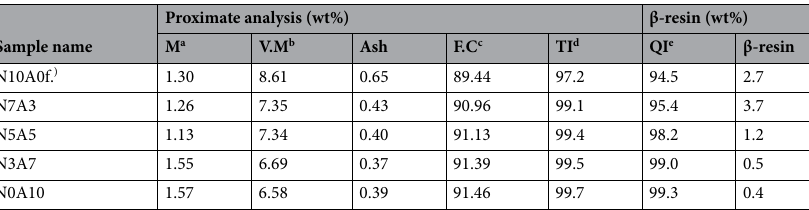
2 100 cc/min/Air 0 cc/